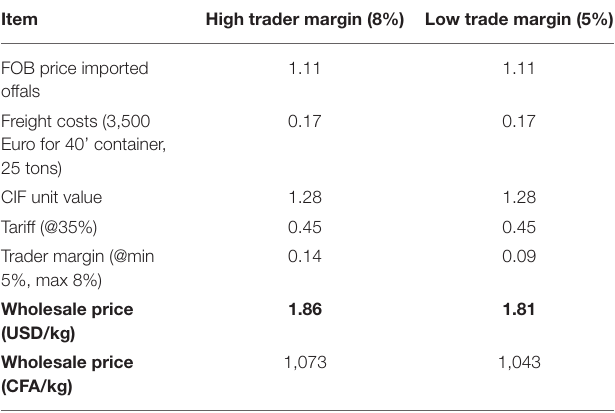
TABLE 4 | Estimates of prices of imported offals in the domestic Ghanaian market.